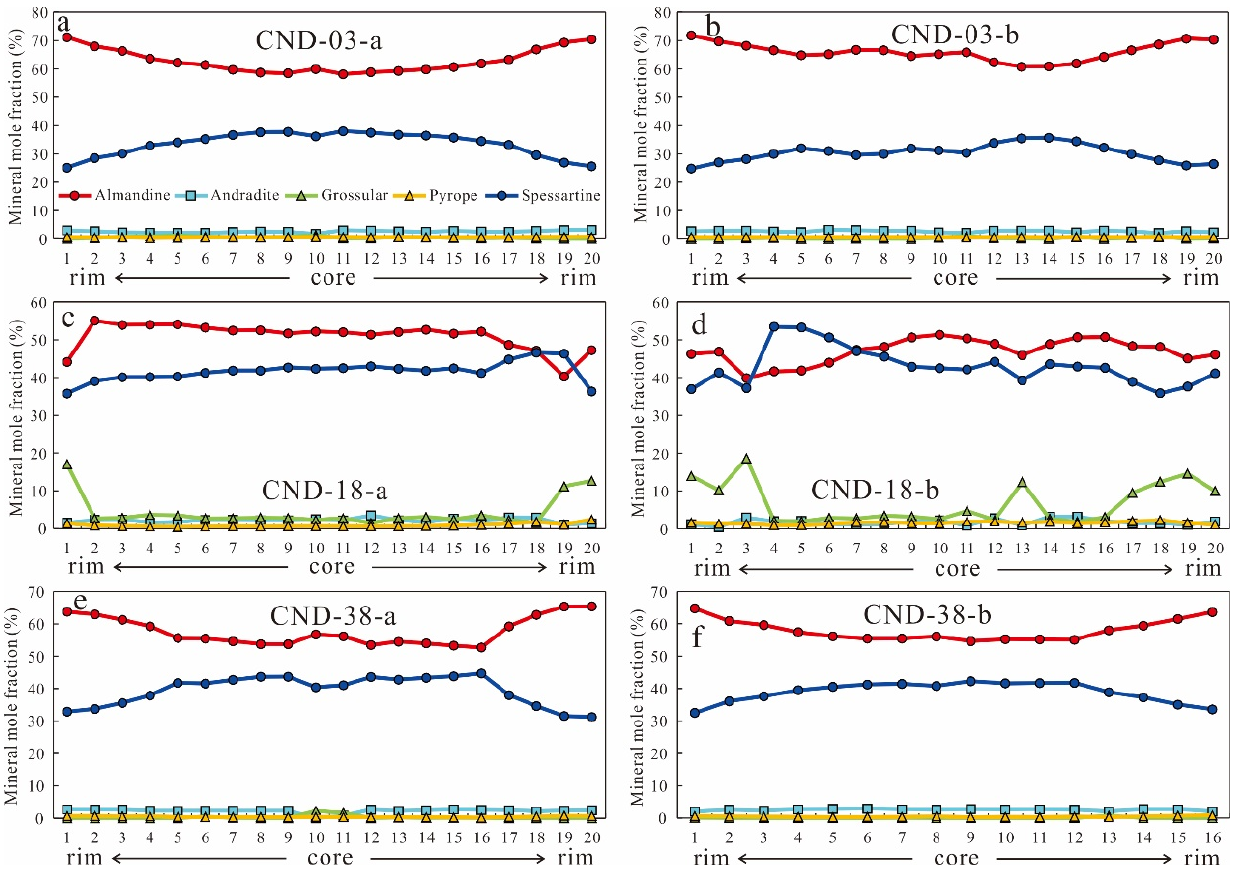
Figure 4. The core – rim chemical profiles of garnets: ( a , b ) garnets from the muscovite granite; ( c – f ) garnet grains from the pegmatite.